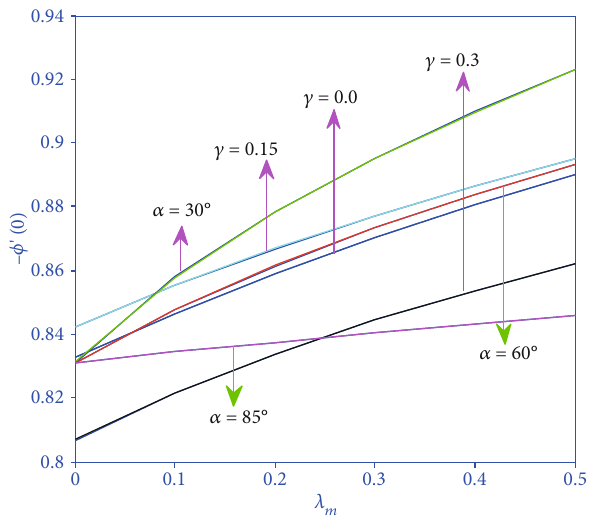
Figure 32: E ff ects of curvature and inclination parameters on the mass transfer rate.